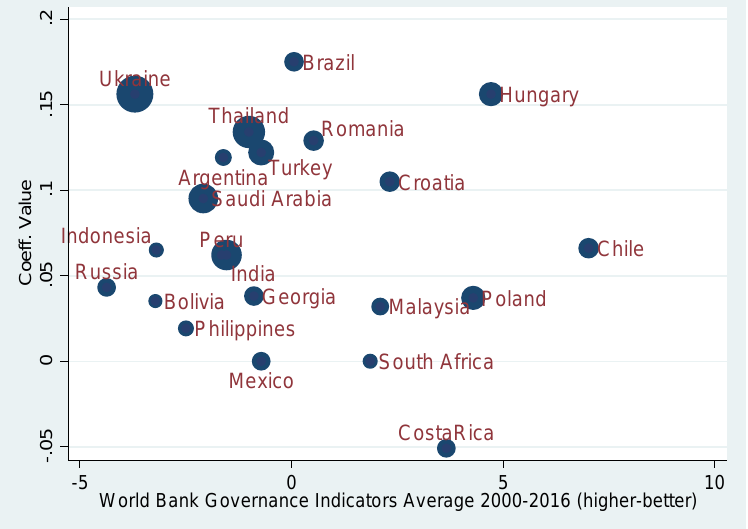
Worldwide Governance Indicators database (https://info.worldbank.org/governance/wgi/). The index is the total